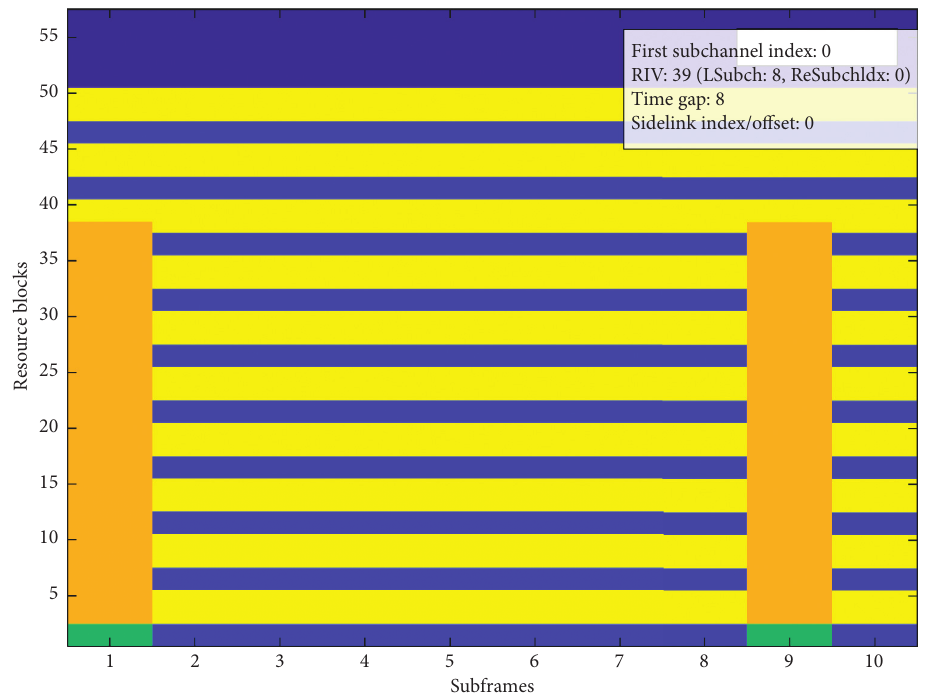
Figure 3: V2V resource pool for resource allocation.